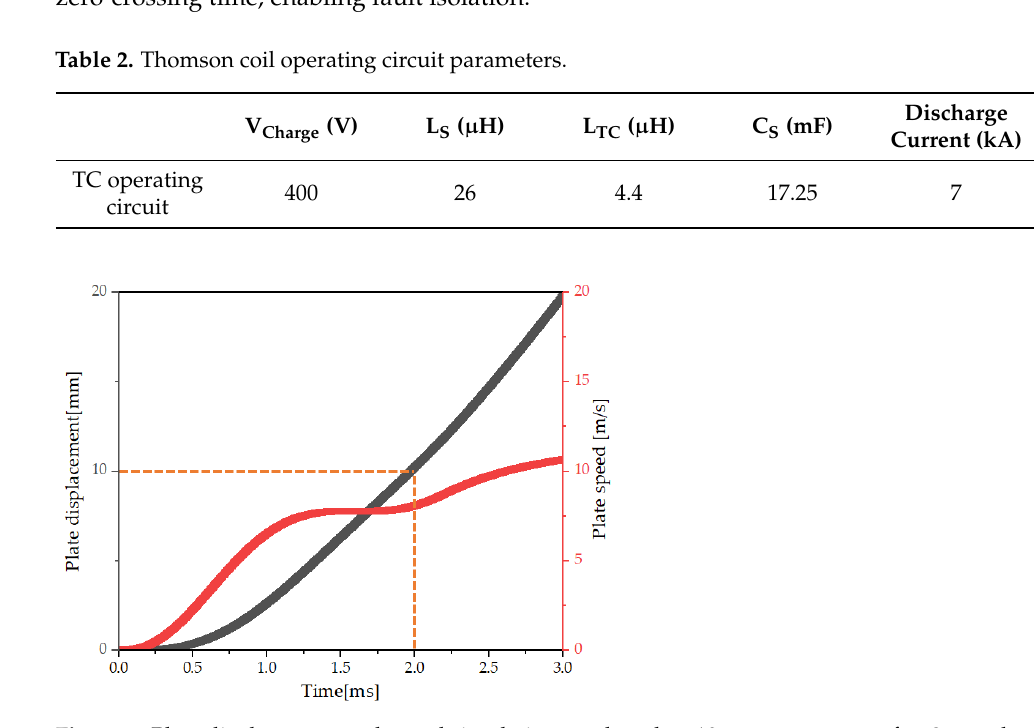
Figure 8. Plate displacement and speed simulation results: plate 10 mm movement after 2 ms when current is applied to TC.